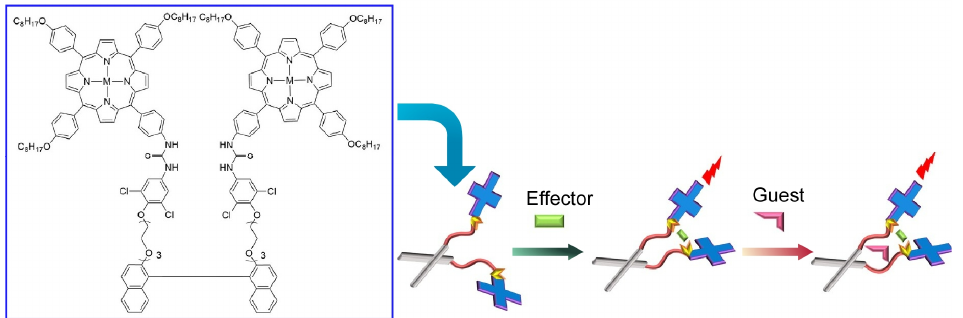
Figure 4. Chemosensor controlled using chiral dianions as effectors to be capable of second excited- state fluorescence upon guest binding. Reprinted with permission from Reference [130]. Copyright 2022 Chemical Society of Japan.